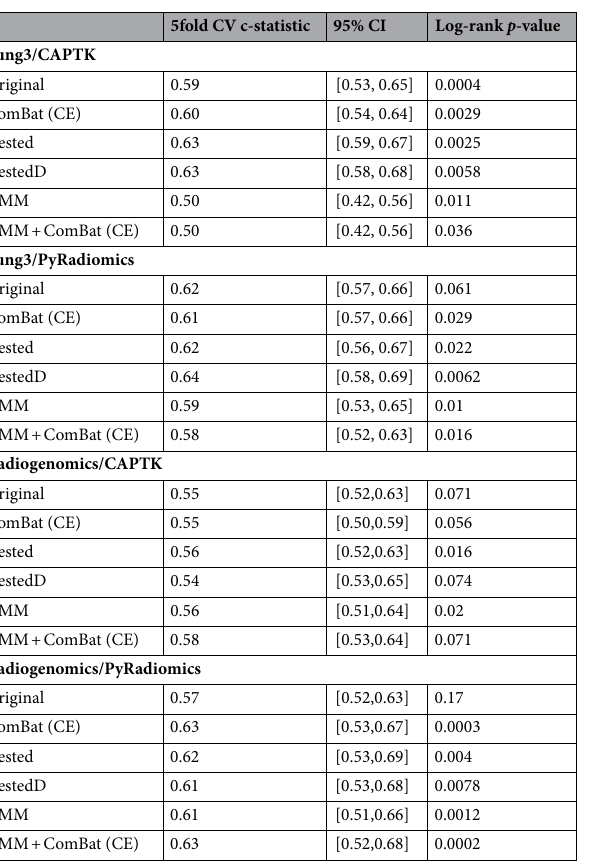
Table 3. C-statistics and 95% confidence intervals (CI) for fivefold cross-validated Cox proportional hazard models built from harmonized data, and log-rank p -values for Kaplan–Meier curve separation. ComBat (CE) indicates data was harmonized by contrast enhancement with